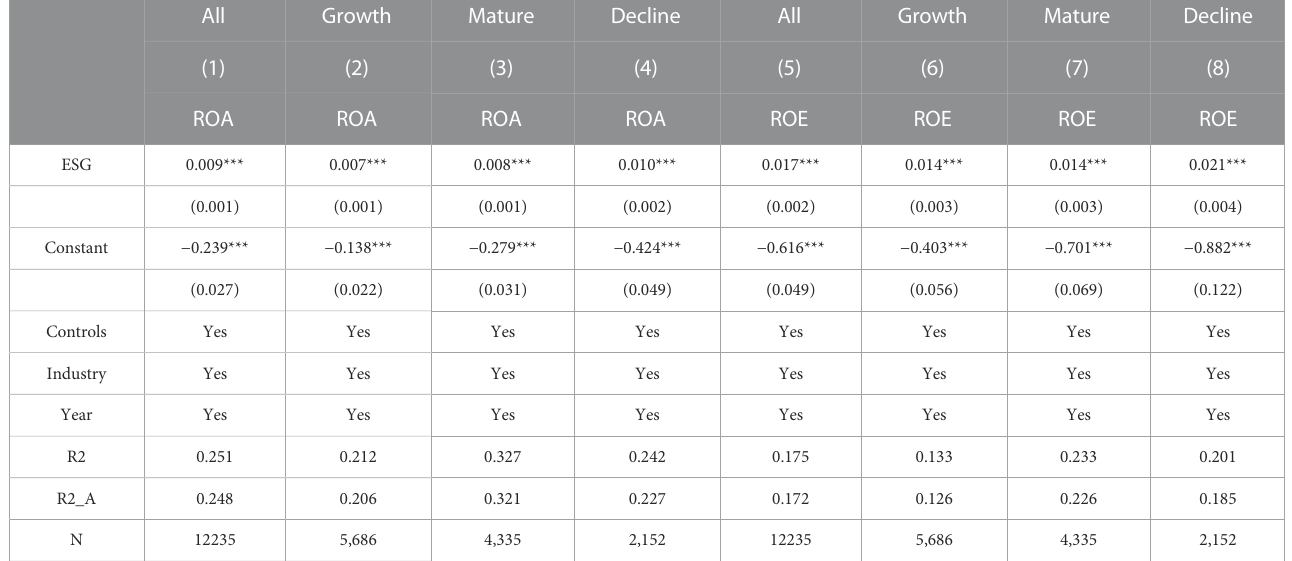
TABLE 12 Replacement of independent